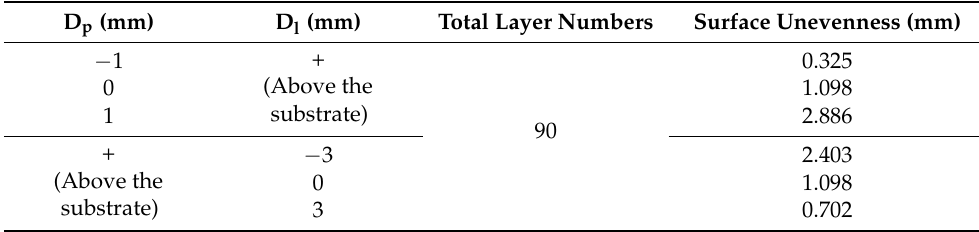
Table 2. Maximum values of 316L thin-walled parts’ top surface unevenness measured with differ-